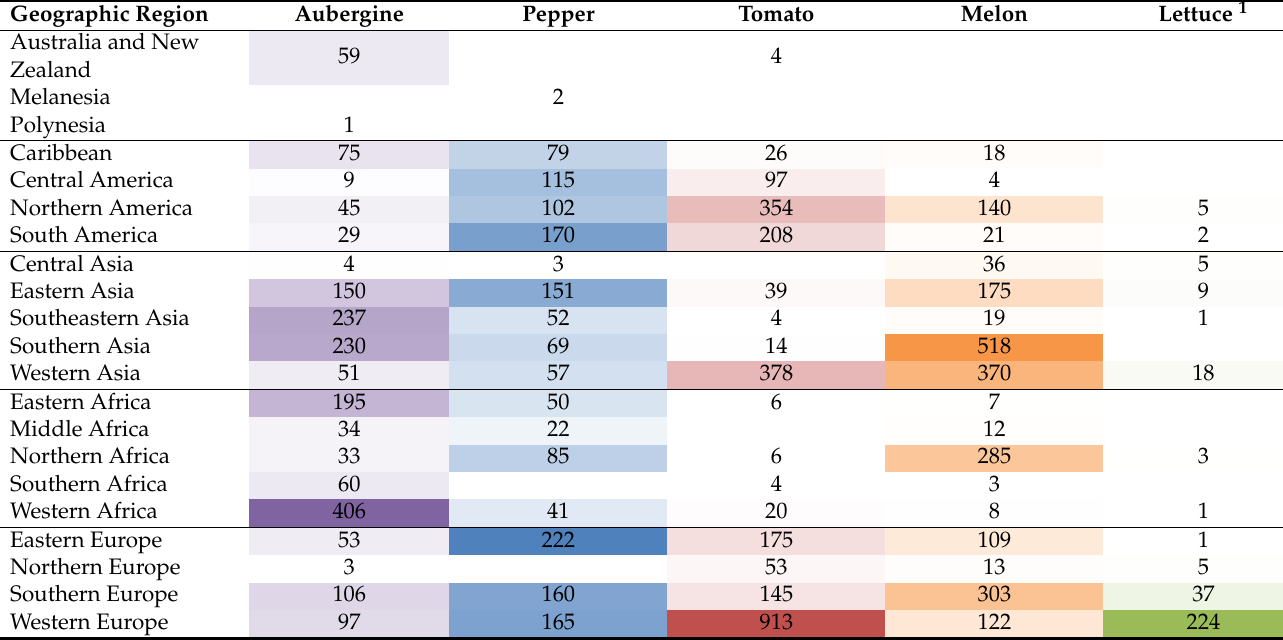
Table 1. Number of accessions originating from the different regions of the United Nations Statistical Division. Note that sometimes the recorded origin is that of the original collection, even if the accession was introduced from a foreign country. The colour scale ranges from dark (most represented region) to light (least represented